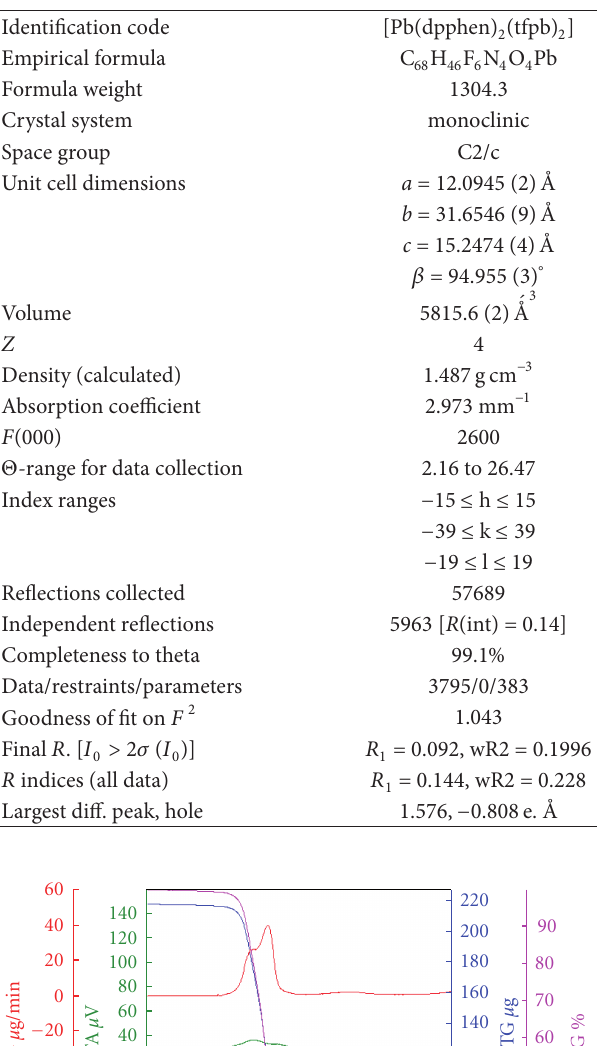
T 1: Crystal data and structure re�nement for (1)